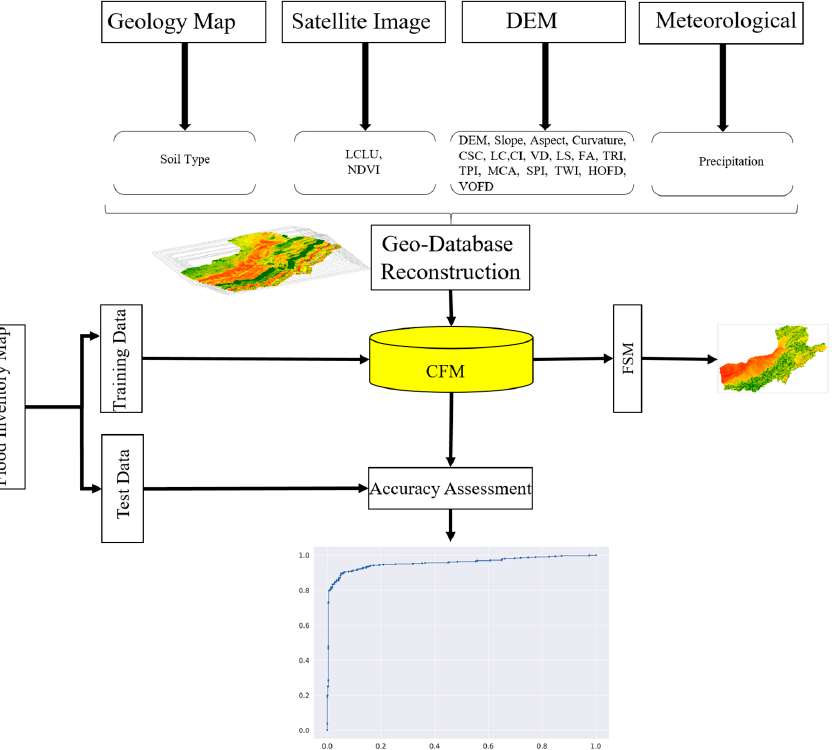
Figure 1. Overview of the proposed Flood Susceptibility Mapping (FSM) based on the Cascade Forest Model (CFM). Digital Elevation Model (DEM), Cross-Sectional Curvature (CSC), Longitudinal Curvature (LC), Convergence Index (CI), Valley Depth (VD), LS factor (LS), Flow Accumulation (FA), Terrain Ruggedness Index (TRI), Topographic Position Index (TPI), Modified Catchment Area (MCA), Stream Power Index (SPI), Topographic Wetness Index (TWI), Horizontal Overland Flow Distance (HOFD), Vertical Overland Flow Distance (VOFD), Land Use/Land Cover Map (LULC), and Normalized Vegetation Index